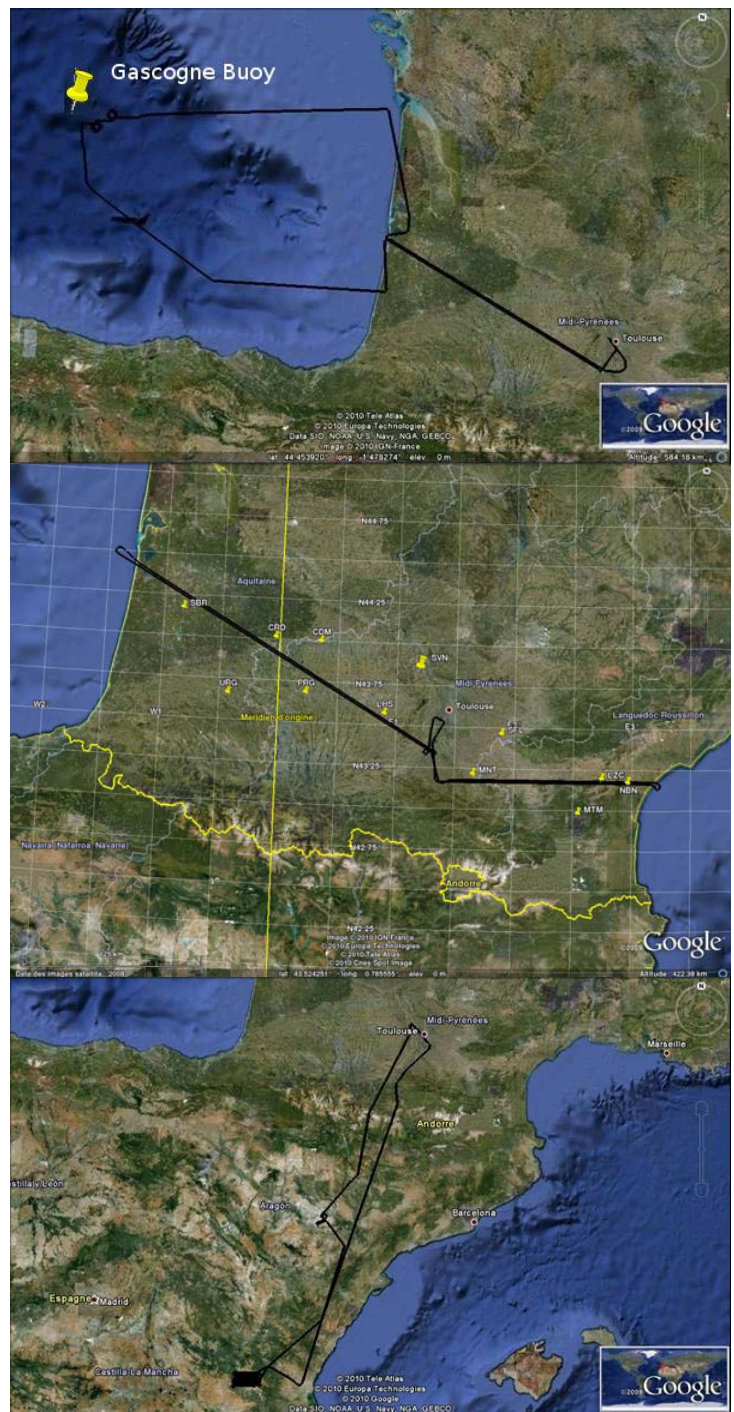
Figure 7. Illustration of flight transects, a (top) illustration of one ocean flight transect over the Gulf of Biscay, b (middle) Illustration of a SMOSMONIA flight transect. Markers are pointing to the location of the 12 SMOSMANIA measurement sites, c (bottom) Illustration of a Valencia transect